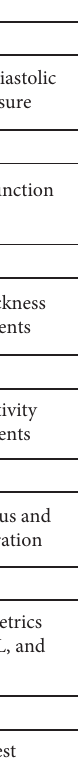
Figure 1: Sequence of measurement procedures. WC- waist cir- cumference, TC- thigh circumference, TL- thigh length, and LLL- lower-limb